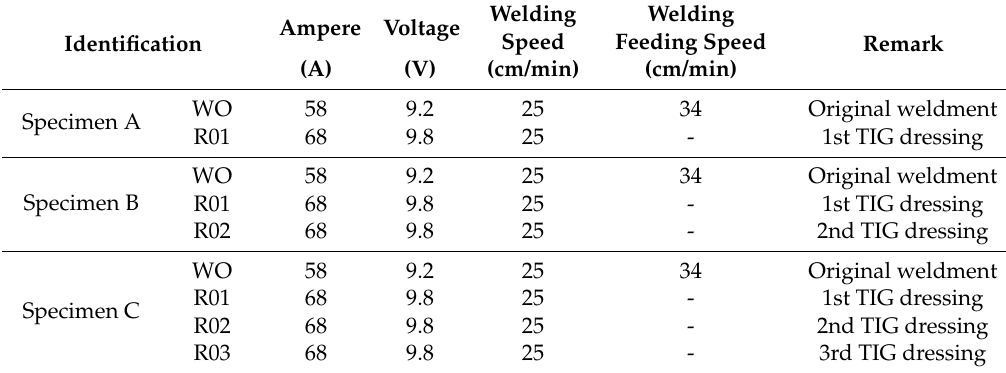
Table 2. Welding and TIG dressing parameters.